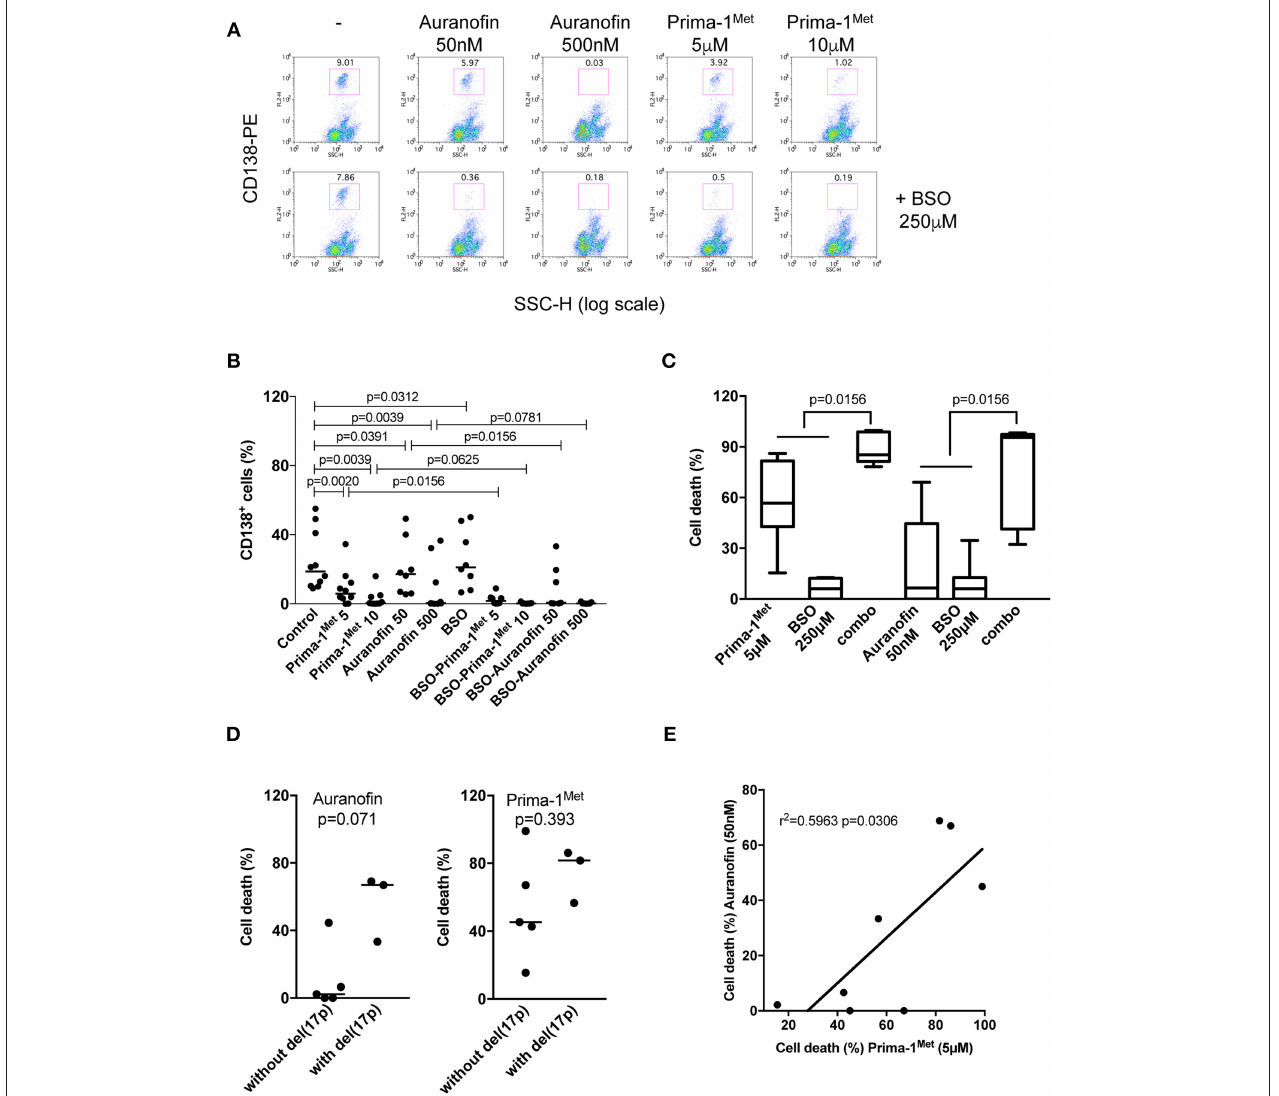
FIGURE 3 | Primary myeloma cells were similarly sensitive to Prima-1 Met and to auranofin. (A) Mononuclear cells from patient #4 with myeloma were incubated for 24 hours with or without (-) Prima-1 Met (5 or 10 µ M) or auranofin (5 or 10 µ M) and stained with anti-CD138-PE. Viability was assessed by CD138 expression. (B) Mononuclear cells from 10 samples were incubated for 24 hours with Prima-1 Met (5 or 10 µ M) or auranofin (5 or 10 µ M) with or without BSO (250 µ M), and stained with anti-CD138-PE. The statistical analyses were performed using the Wilcoxon matched-pairs signed-rank test. (C) Cell death induced by Prima-1 Met (5 µ M, samples #3,4,5,6,8,9, and 10), auranofin (50nM, samples #3,4,5,6,7,9, and 10) or BSO (250 µ M, samples #3-10) was compared to cell death induced by combinations (combo) of Prima-1 Met or auranofin with BSO. The statistical analyses were performed using the Wilcoxon matched-pairs signed-rank test. (D) Cell death induced by auranofin (50nM) or Prima-1 Met (5 µ M) was analyzed according to del(17p) status. The statistical analyses were performed using the Mann-Whitney test. (E) Myeloma cell death induced by 5 µ M of Prima-1 Met was plotted against cell death induced by 50nM auranofin. Correlation was performed using the Pearson